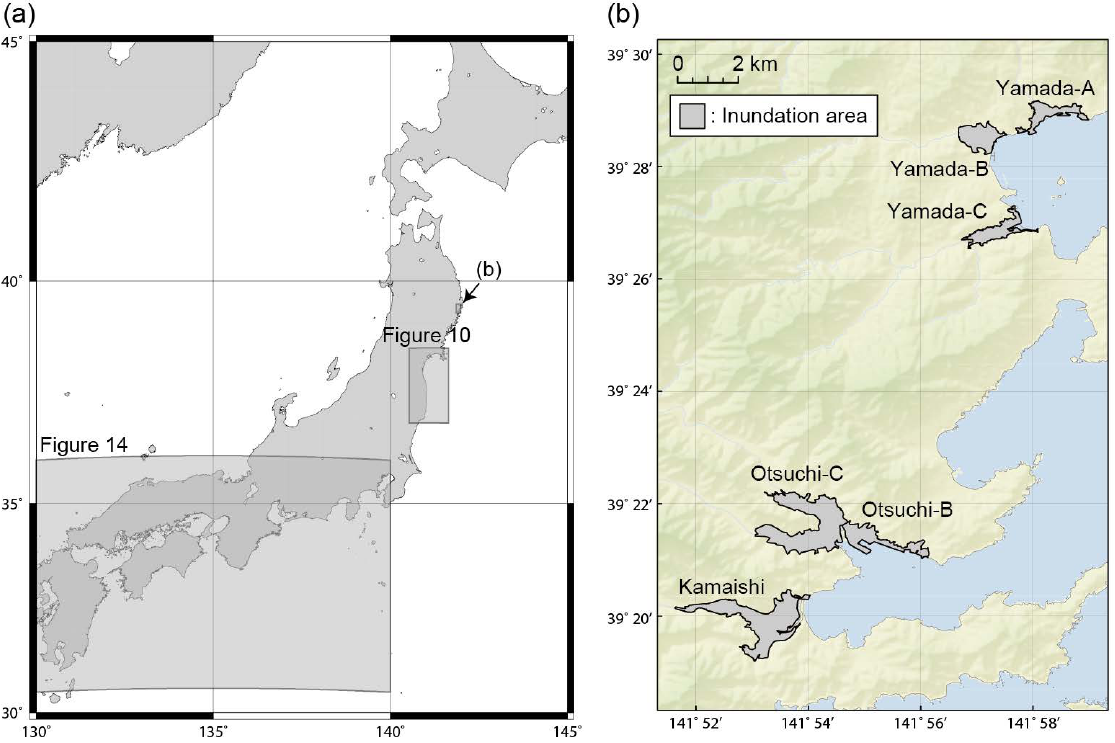
Figure 2. ( a ) Over view of analysis area in Japan, ( b ) Analysis areas for evaluation of tsunami debris. In these areas, high-quality, high-resolution laser imaging detection and ranging (LiDAR) were conducted by the Geospatial Information Authority of Japan immediately after the 2011 Tohoku-oki earthquake tsunami. The resulting digital surface model (DSM) of the inundation area includes the height of the debris generated by the tsunami. The distribution thickness and volume of the debris was calculated from the difference between this DSM and the digital elevation model (DEM) for the corresponding area, based on measurements obtained before the earthquake, following Koshimura and Fukuoka